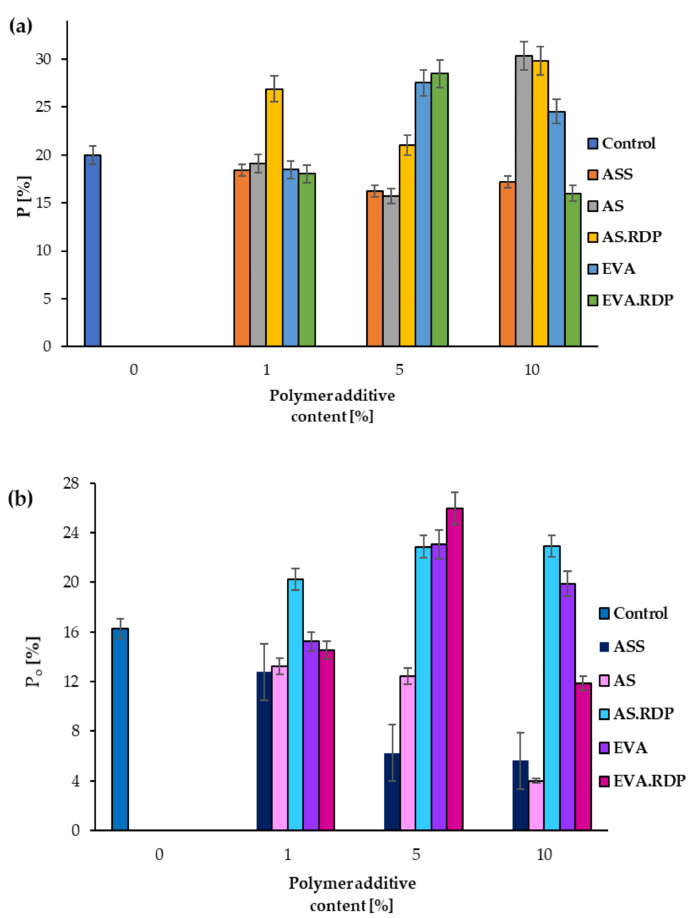
Figure 11. The total porosity ( a ) and open porosity ( b ) of the studied composites. The data presented in Figure 12 indicate that in the studied work the introduction of polymeric additives in different forms, in most scenarios, causes a decrease of values of open pores volume. This does not, however, result in the higher values of the studied mechanical properties. Only in the case of composites containing water dispersion of a styrene-acrylic ester copolymer (silanised), the studied materials achieve higher or equal values of flexural strength and comprehension strength compared to the control sample.